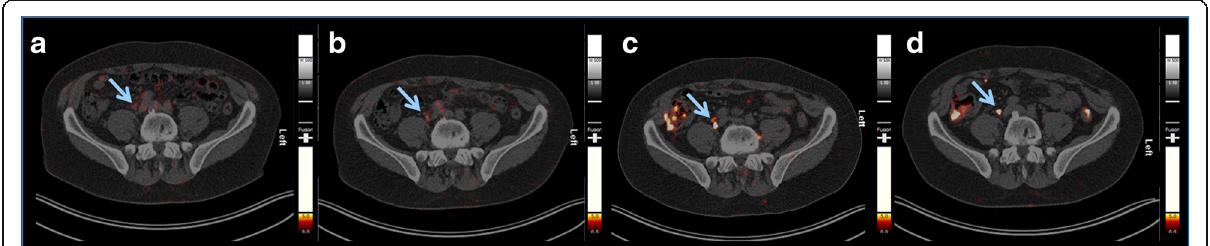
Fig. 5 PET/CT scans (transversal slices through the lower abdomen at the entrance level of the pelvis) obtained at a 50 min, b 2 h, c 18.5 h, and d 25 h, respectively after injection of 140 MBq 152 Tb-PSMA-617, revealing a small lymph node metastasis (< 8 mm in size) near the right common iliac artery (blue arrow) with maximum uptake observed at 18.5 and 25 h p.i.